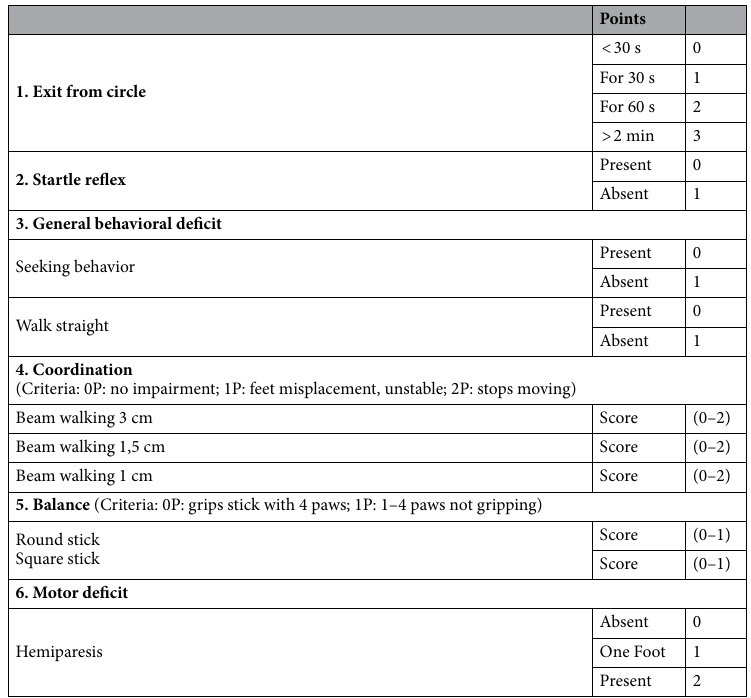
Table 1. Modified Neurological Severity Score. The modified Neurological Severity Score was designed on the basis of the Neurological Severity Score introduced by Tsenter and colleagues 29 . The mNSS focusses on motoric function and behavioral deficits and was performed 1 day before CCI and on posttraumatic day 1, 3, and 5 after experimental